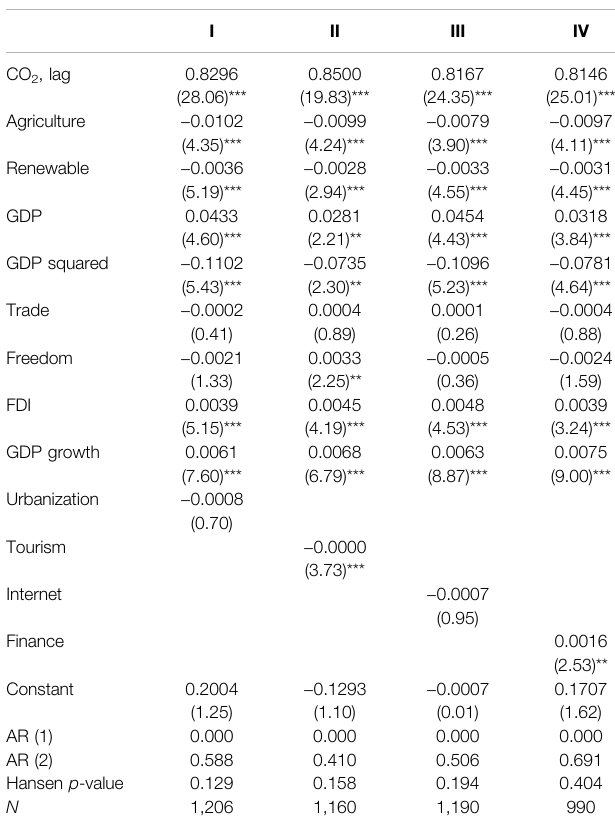
TABLE 4 | Additional